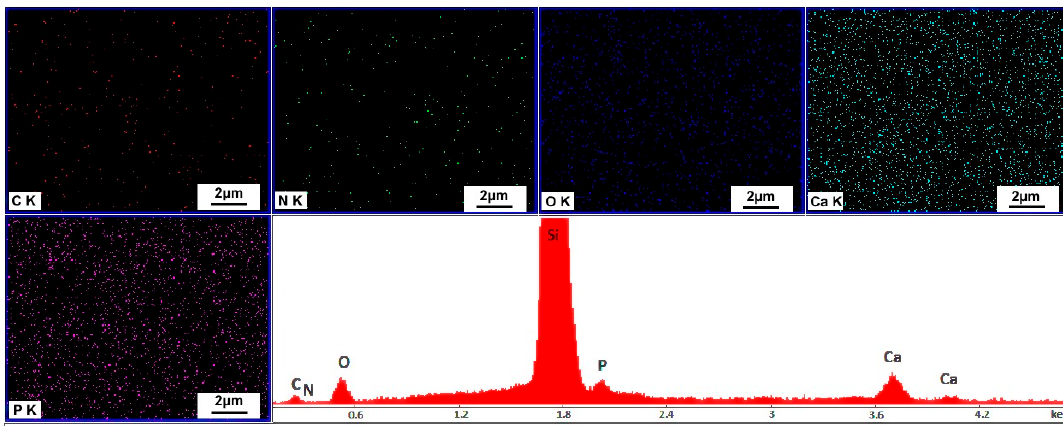
Figure 4. Elemental mapping and typical EDX spectrum of CS–HAp coatings obtained at p = 1.2 × 10 − 2 mbar.